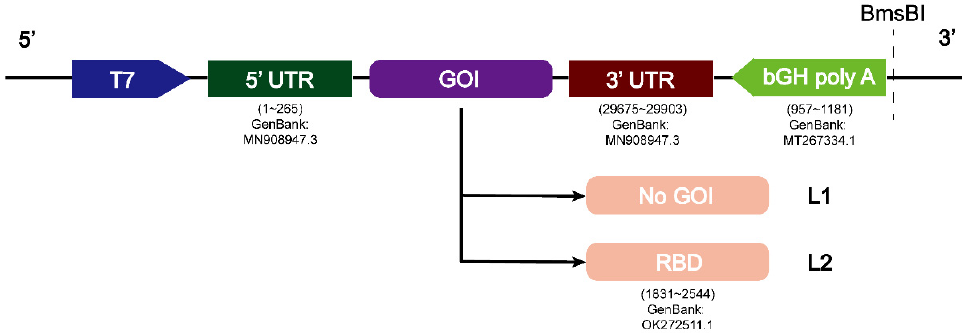
Figure 1. Structures of L1 and L2 containing the SARS-CoV-2 prototype genes. Numbers below the figure indicate the GenBank accession numbers of the gene sequences. GOI, gene of interest.